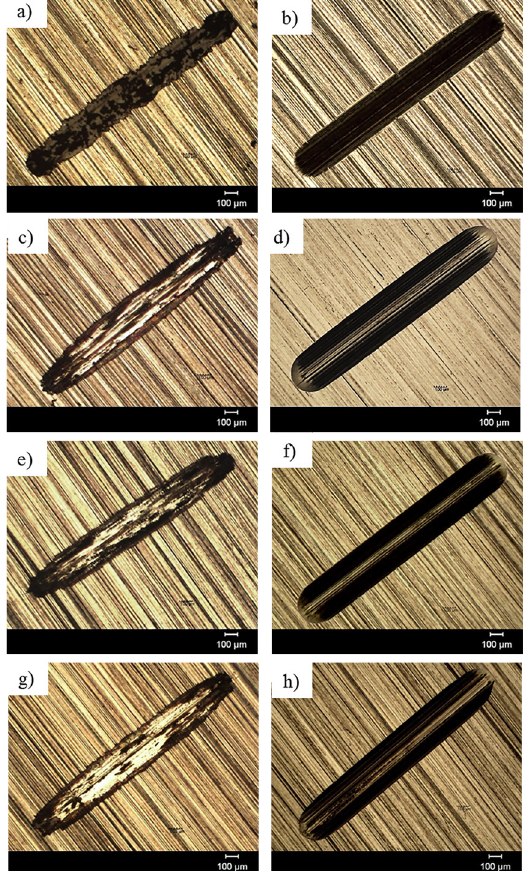
Figure 14: Optical microscopy of the worn tracks. a) As Received in dry condition; b) As Received in corrosive medium; c) Conventional Quenching in dry condition; d) Conventional Quenching in corrosive medium; e) Cryogenic Treatment (-80 ºC) in dry condition; f) Cryogenic Treatment (-80 ºC) in corrosive medium; g) Cryogenic Treatment (-196 ºC) in dry condition; e h) Cryogenic Treatment